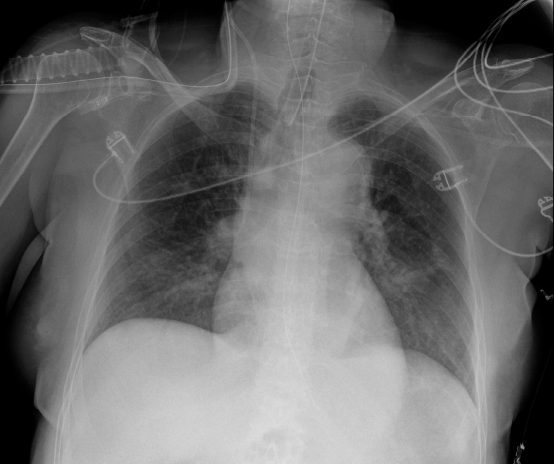
Figure 21. Image of a properly positioned nasogastric tube; also in the image, a well-positioned ETT.